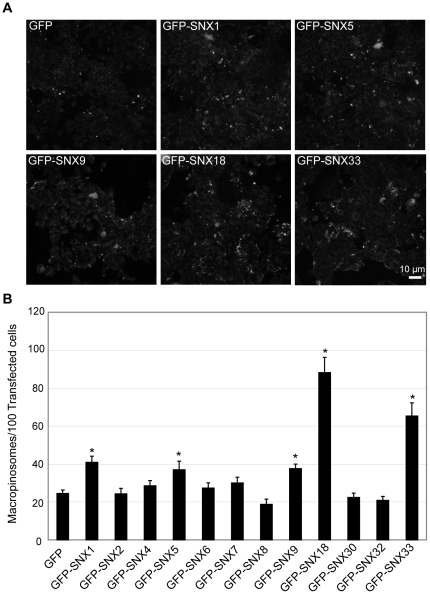
The SNX-PX-BAR family is involved in macropinosome formation.HEK-Flp-In cells transiently overexpressing GFP-tagged members of the SNX-PX-BAR family were assayed for macropinosome formation as described in Materials and Methods. A: Dextran-TR labeling of cells transfected with the specified constructs. Scale bar  = 10 µm. B: The mean number of macropinosomes/100 transfected cells was quantitated over 8 replicates of 500 transfected cells for each condition. * denotes statistical significance (p<0.05) using the Student's T-test, performing pairwise analyses relative to cells transfected with pEGFP-C1 alone. Error bars denote S.E.M.